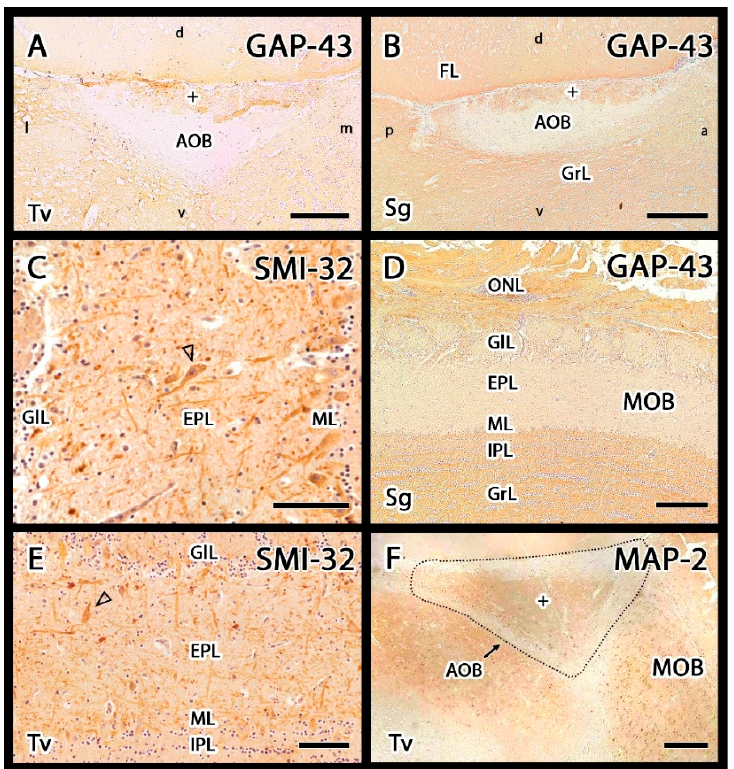
Figure 8. Immunohistochemical study of the olfactory bulb in meerkat (GAP-43, SMI-32 and MAP-2 markers). ( A , B ) Anti-GAP-43 produces in both transverse ( A ) and sagittal ( B ) sections a strong immunopositive labelling in the nerve, glomerular (+) and granular layers (Grl) of the AOB. ( D ) In the MOB Anti-GAP-43 marker showed immunopositivity in the ONL, IPL and GrL. ( C , E ) Anti-SMI-32 immunolabelling; hematoxylin counterstaining. This marker is immunonegative in the AOB, but it produces strong positivity in the principal cells of the MOB (arrowheads). ( F ) Anti-MAP-2 labels the mitral-plexiform and granular layers of the AOB (+) and the plexiform and mitral layers of the MOB. Sg: Sagittal; Tv, Transverse. Scale bars: ( A , C , E , F ) 100 μ m; ( B , D ) 200 μ m.